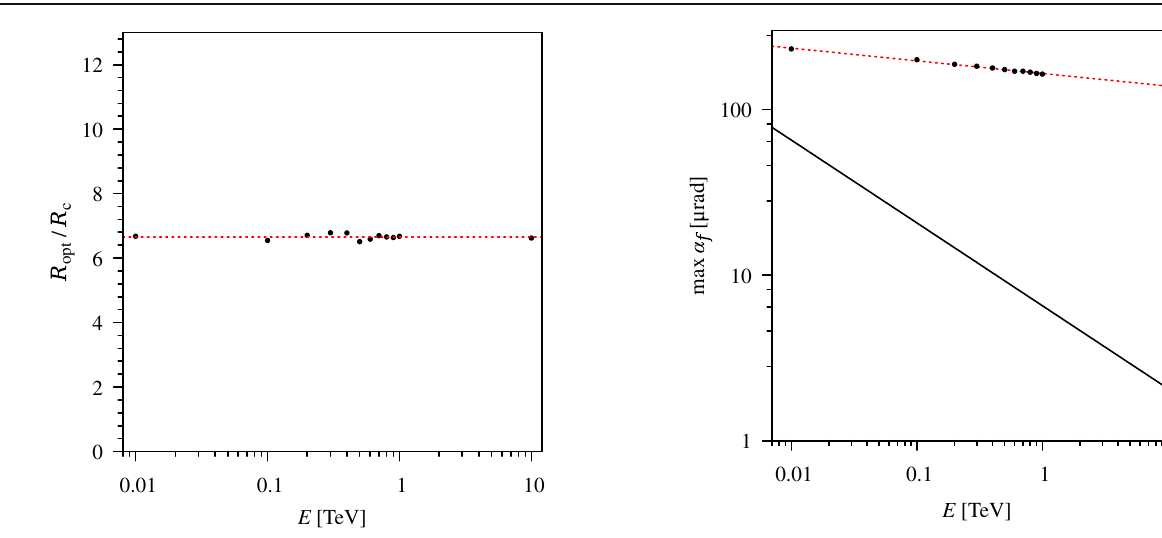
It is important to note that, in accordance with formula (3), the value of α f substantially depends on the fraction of beam particles that must be deflected by a bent crystal. In Fig. 7 we shown this dependence for E = 300 GeV. Simulation results are depicted by dots, while line shows the value of the critical angle of planar channeling. One can see that with a decrease in f the max α f is growing rapidly. However, it should be noted that planar channeling makes it possible to deflect only a smaller part of the beam of negatively charged particles. And the smaller this part, the more it can be